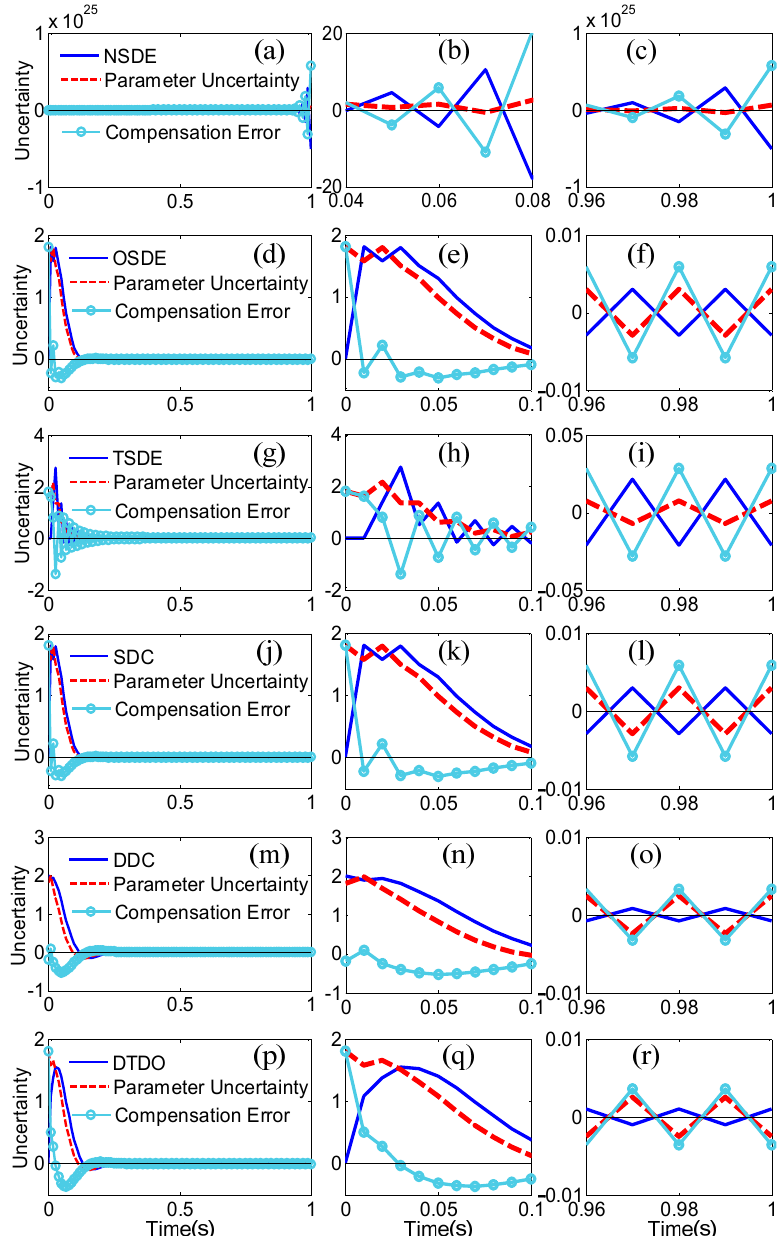
Figure 1. Disturbance compensators, parameter uncertainties and compensation errors: ( a ) N ‐ steps delay estimation (NSDE); ( b , c ) Zoom view of Figure 1a; ( d ) One ‐ step delay estimation (OSDE); ( e , f ) Zoom view of Figure 1d; ( g ) Two ‐ step delay estimation (TSDE); ( h , i ) Zoom view of Figure 1g; ( j ) Sliding mode control disturbance compensator(SDC) ( k , l ) Zoom view of Figure 1j; ( m ) Decoupled disturbance compensator (DDC); ( n , o ) Zoom view of Figure 1m; ( p ) Discrete ‐ time disturbance observer (DTDO); ( q , r ) Zoom view of Figure 1p.